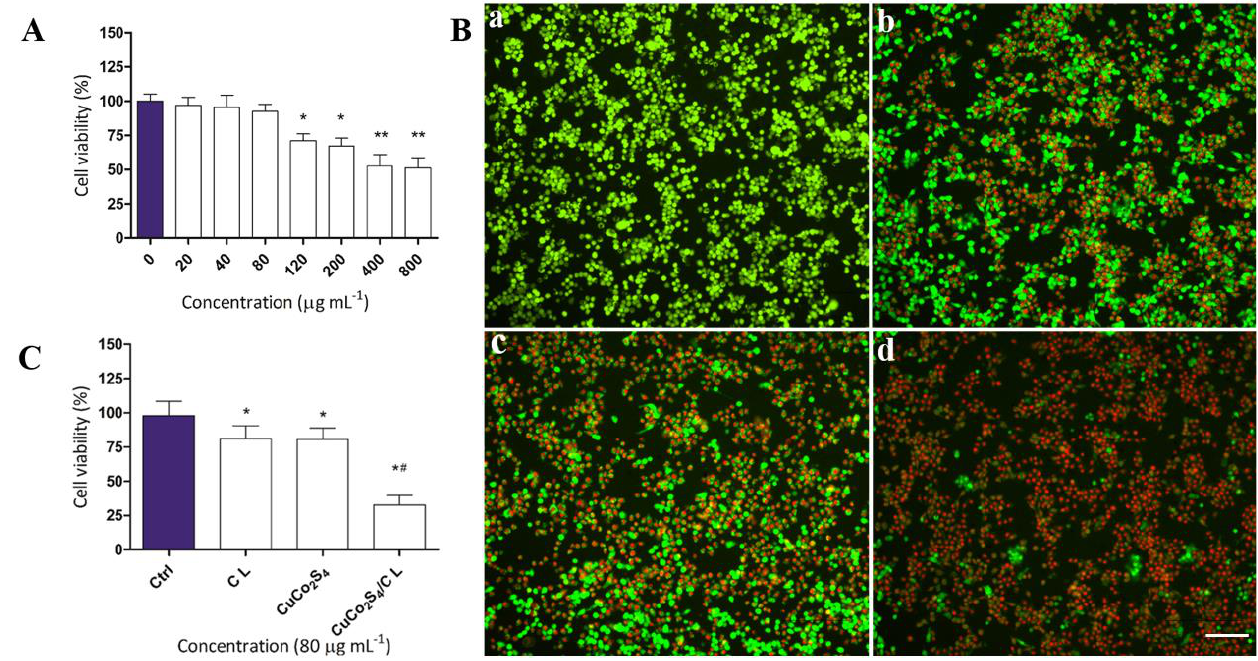
Figure 4. Cytotoxicity and PTT effect of CuCo 2 S 4 NCs/CL on Raw264.7 cells. ( A ) Relative cell − viability of Raw264.7 cells cultured with the indicated concentrations of CuCo 2 S 4 NCs/CL for 12 h. *: p < 0.05, **: p < 0.01. ( B ) Representative images of dead (red, Calcein AM)/live (green, PI) Raw264.7 cells cultured with ( a ) PBS and 80 ppm of ( b ) CuCo 2 S 4 NCs, ( c ) CL, ( d ) CuCo 2 S 4 NCs/CL, then irradiated using the 808 nm NIR laser with a power density of 0.56 W cm − 2 . Scale bar = 100 μm. ( C ) Cell viability of Raw264.7 cells cocultured with PBS (Control) and 80 ppm of CL, CuCo 2 S 4 NCs, CuCo 2 S 4 NCs/CL followed by the 808nm NIR laser irradiation. *: p < 0.05 vs. control, # : p < 0.05 vs. CL.